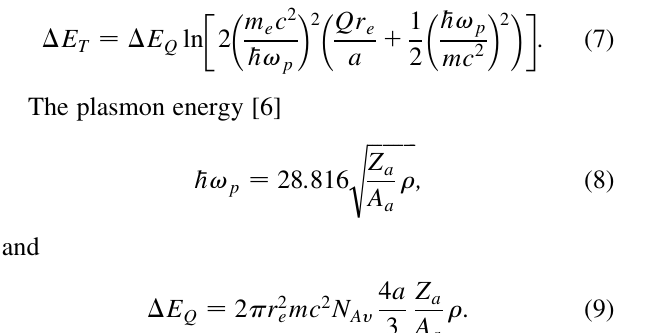
(cid:6) a (cid:7) given by the limit on the free path FIG. 2. Parameter Q 1 length of secondary electrons, see